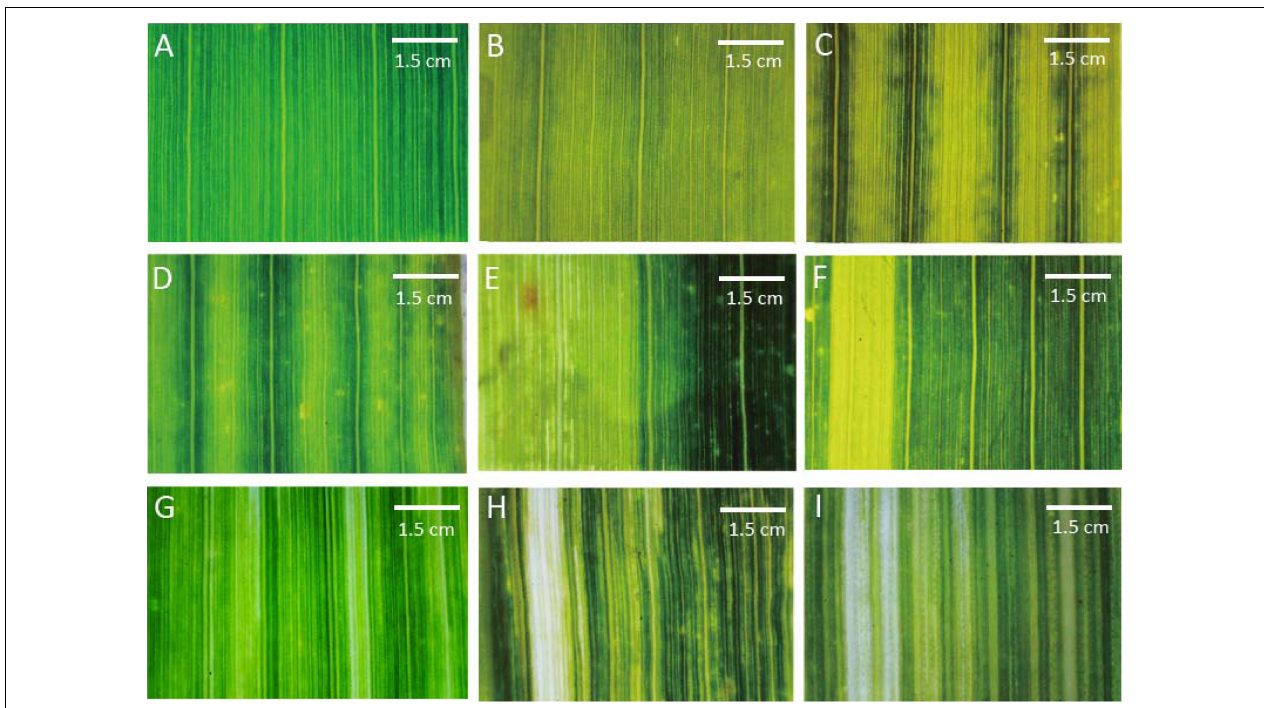
FIGURE 2 | Mutant classifications after a microscopic analysis of leaf vein arrangements. (A) Wild-type Yugu1; (B) light yellow leaves ( t15 ); (C) yellow and green striped leaves ( t216 ); (D) light green striped leaves ( t38 ); (E) yellow and green leaves ( t261 ); (F) thick yellow striped leaves ( t267 ); (G) thin yellow striped leaves ( t198 ); (H) thick white striped leaves ( t197 ); and (I) thin white striped leaves ( t189 ). Scale: 1.5 cm.